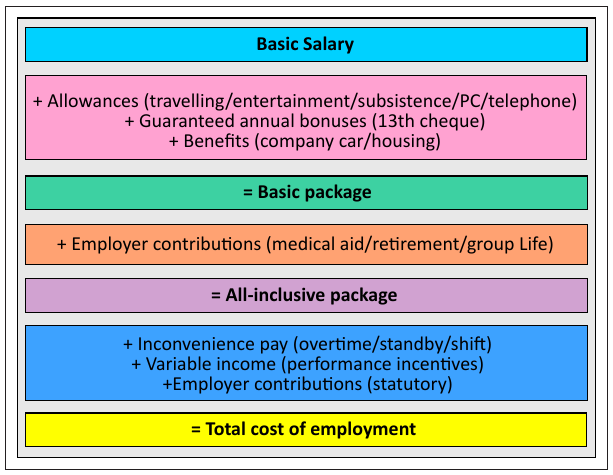
FIGURE 1: Remuneration